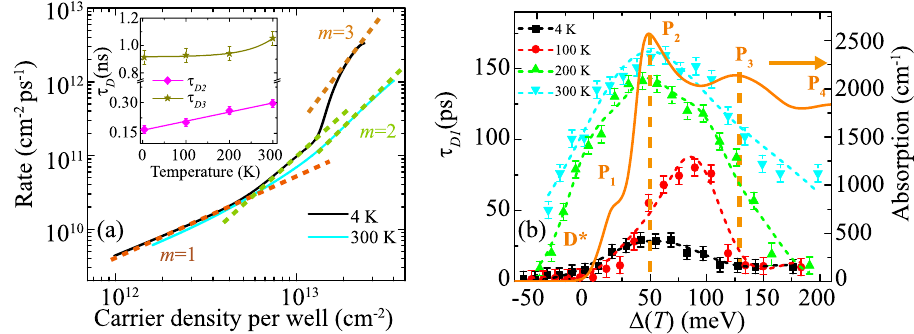
Figure 5. ( a ) Relaxation and/or recombination rate of excited-state carriers for 1.03-eV excitation at 4 K (black) and 300 K (cyan). Dashed guides to the eye represent known recombination mechanisms. Inset: temperature dependence of decay times τ D 2 and τ D 3 , averaged over excess-photon energy. ( b ) Excess-photon energy dependence of fast decay time ( τ D 1 ) fit with five Gaussian distributions centered at D* and P 1 - P 4 (dashed lines). The latter are determined from the simulated optical absorption (solid